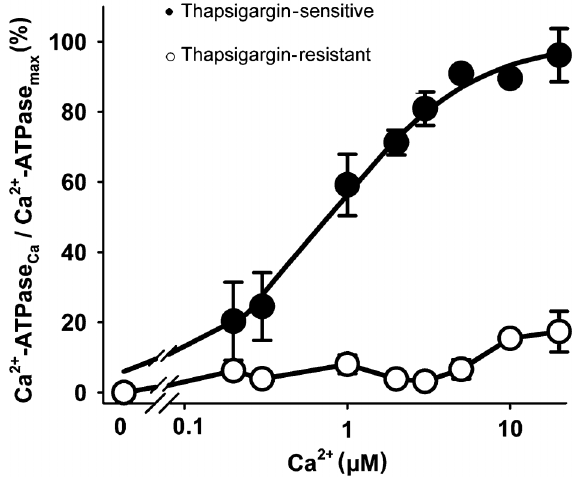
Figure 1. Ca 2 + concentration dependence of thapsigargin- sensitive and -resistant Ca 2 + -ATPase activity. The assays were performed in triplicate and data are reported as means ± SE for